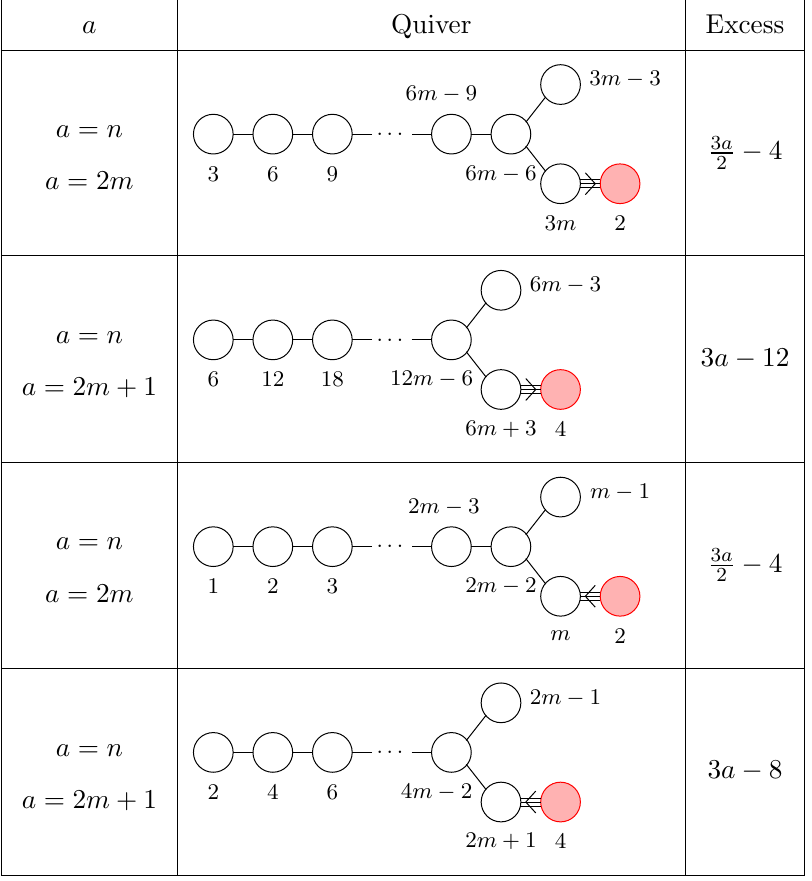
Table 17 . Exotic minimally unbalanced quivers with G = SO(2 n ) and a triple laced